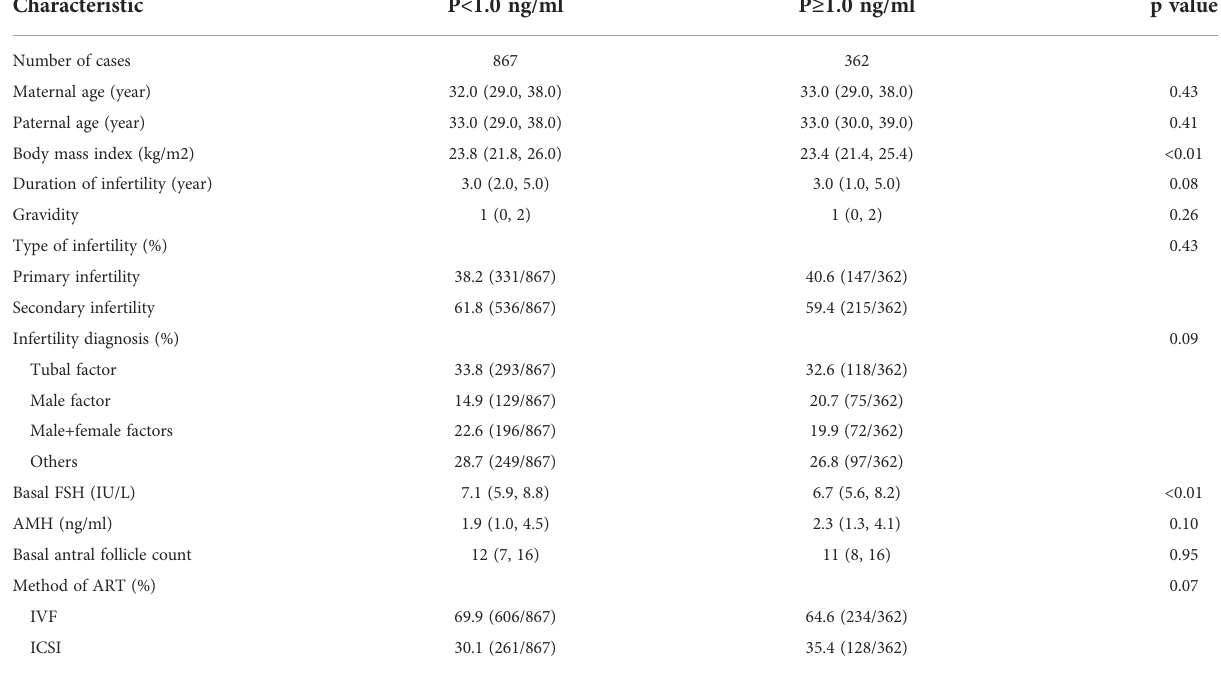
TABLE 1 Characteristics of the participants at